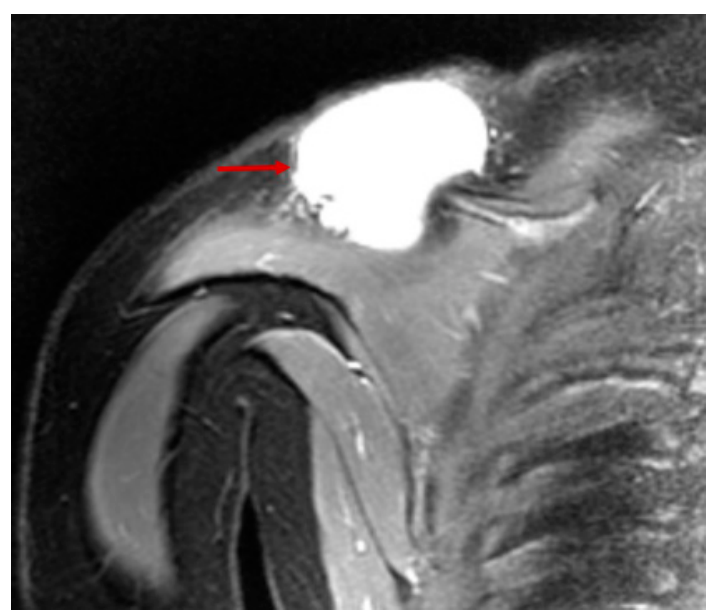
Figure 9. Coronal MRI of extraosseous Ewing sarcoma. Note cystic nature of lesion on T2 weighted image.